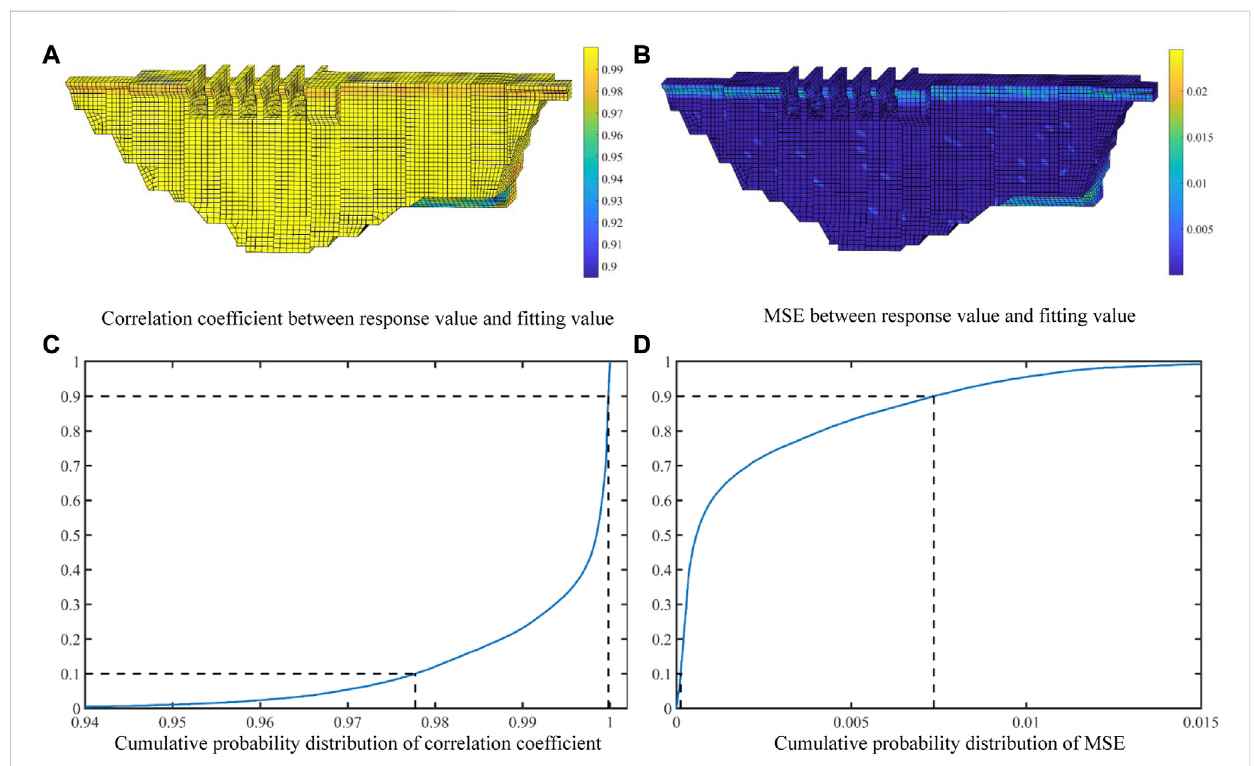
FIGURE 9 (A,B) correlation coef fi cient and MSE distribution of temperature behavior surrogate model within the dam body; (C,D) cumulative probability distribution of correlation coef fi cient and MSE of temperature behavior surrogate